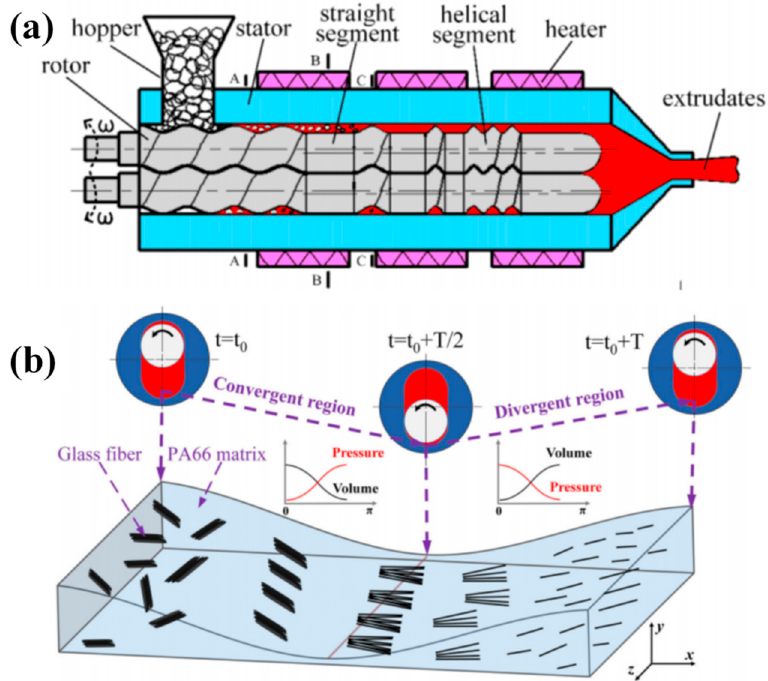
Figure 11. Schematic illustration of ( a ) overall structure of TERE. Reproduced under the CC BY- NC-ND license from [17]. and ( b ) the dispersion mechanism of glass fiber (GF) in the PA66 matrix. Reproduced with permission from [67]. Copyright 2020, John Wiley and Sons.